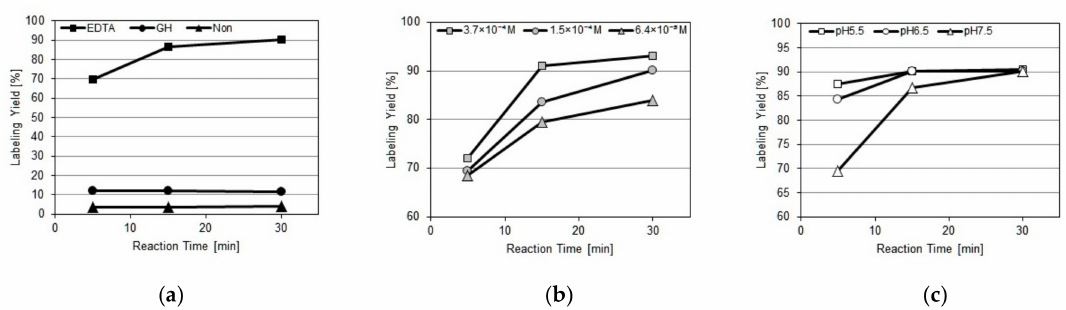
Figure 2. Thin-layer radiochromatography (TLC) of 99m Tc-N 2 S 2.